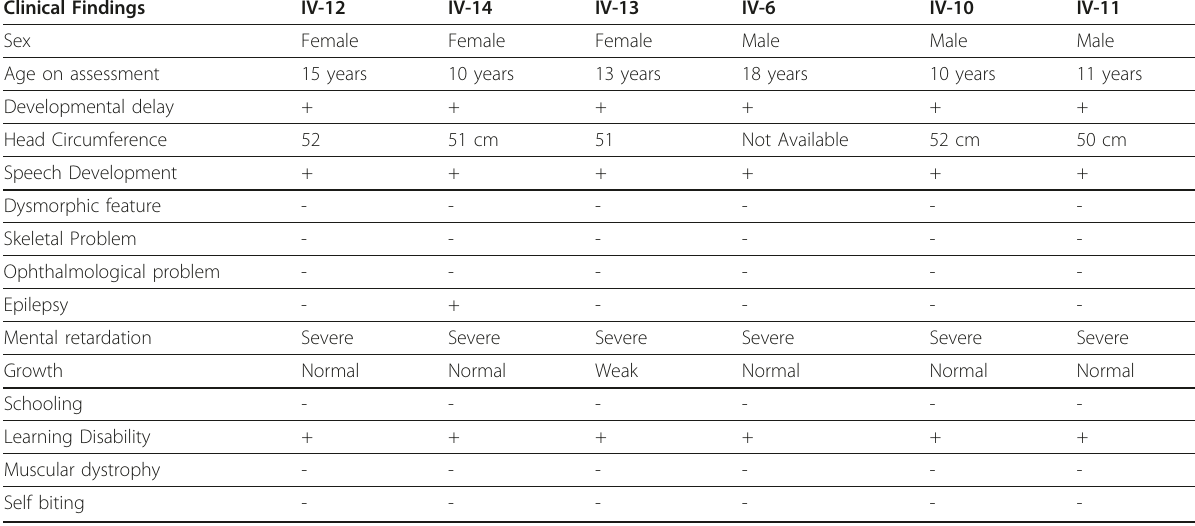
Table 1 Summary of the clinical data of affected individuals Clinical Findings